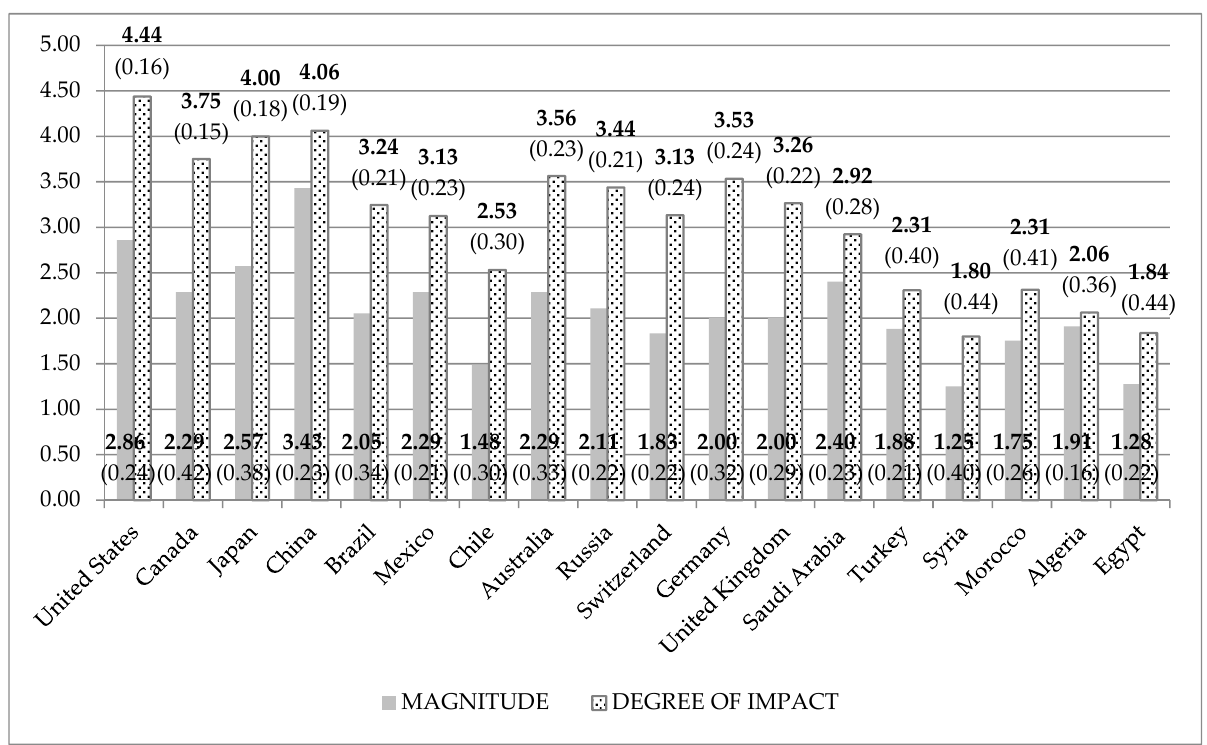
Figure 3. Magnitude of annual increase in world demand for olive oil and its degree of impact on Spanish exports (overall mean and coefficient of variation). Note: Values represent (a) mean annual growth on a four-point scale from “very moderate increase” to “very sharp increase” (figures down in the chart), and (b) mean impact on a five-point scale from “insignificant” to “very significant” (up in the chart). Coefficient of variation values are displayed in parentheses.